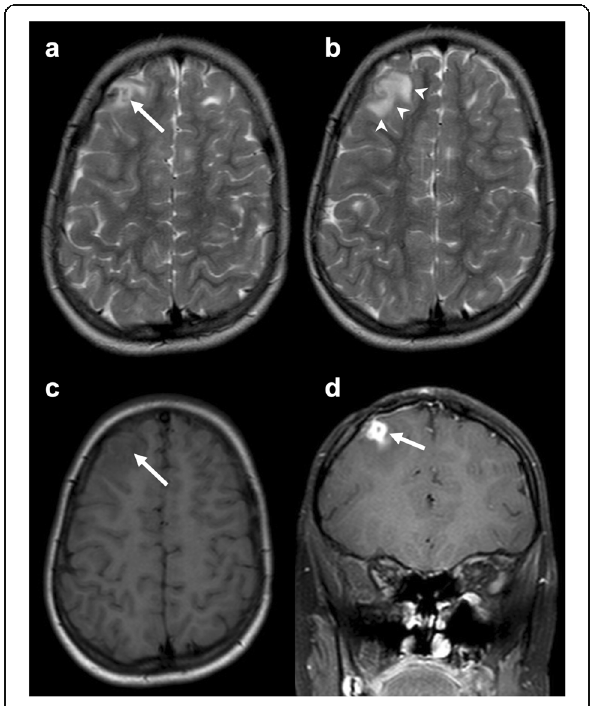
Fig. 5 Suture material-induced granuloma. Axial T2-weighted ( a , b ) and unenhanced T1-weighted ( c ) images and coronal contrast- enhanced T1-weighted ( d ) showing a mass (arrow) in the right frontal superior gyrus with low signal on both T1- and T2-weighted sequences, surrounded by vasogenic edema (arrowheads), with rim enhancement. Some tubers are detectable in the axial images as the patient was affected by tuberous